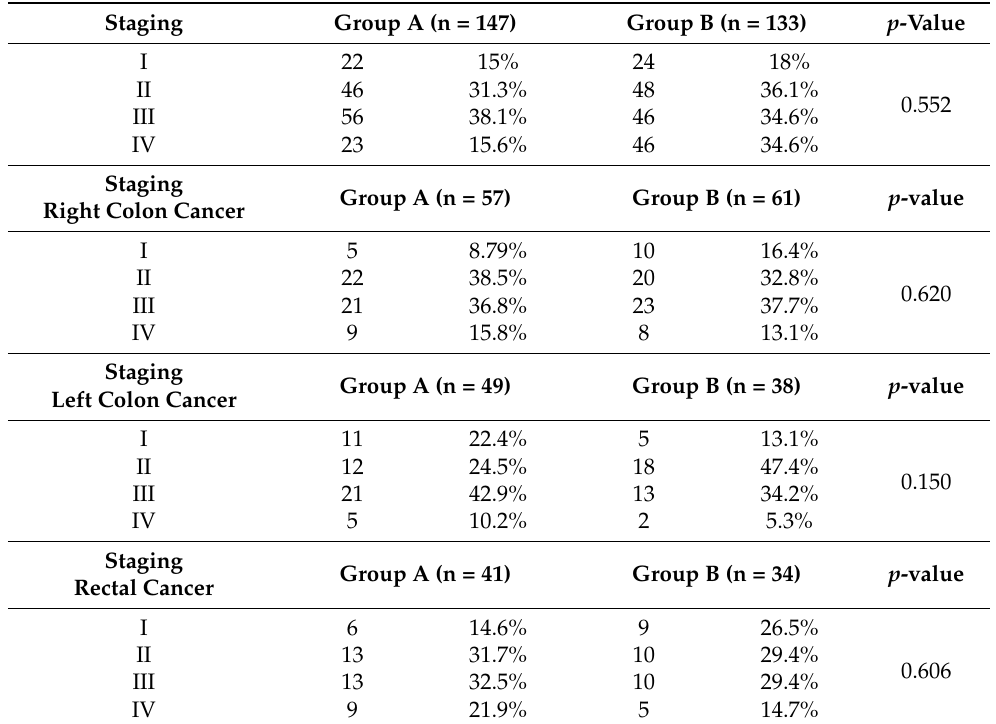
Table 2. Primary